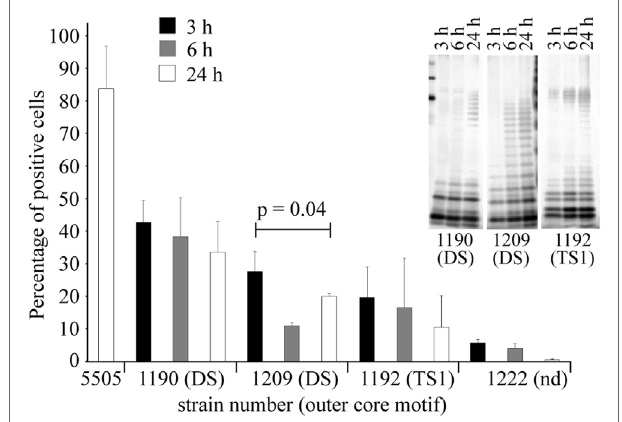
FigUre 6 | Growth phase-dependence of hMBL– Hafnia alvei interactions observed in FACS analyses. Binding of hMBL to inactivated smooth H. alvei PCM 1190, 1192, and 1209 bacterial cells at the lag (black bars), exponential (gray bars), and the stationary phases (white bars) of growth. Silver stained SDS-PAGE (inset) of LPS 1190, 1209, and 1192 isolated from bacterial mass collected at lag, log, and stationary phases. Data represent the mean values ± SD from three independent experiments. DS and TS1 stand for the disaccharide and trisaccharide outer core motif in LPS of selected H. alvei strains. Abbreviations: Nd, not determined; hMBL, human MBL; PCM, Polish Collection of Microorganisms; LPS,